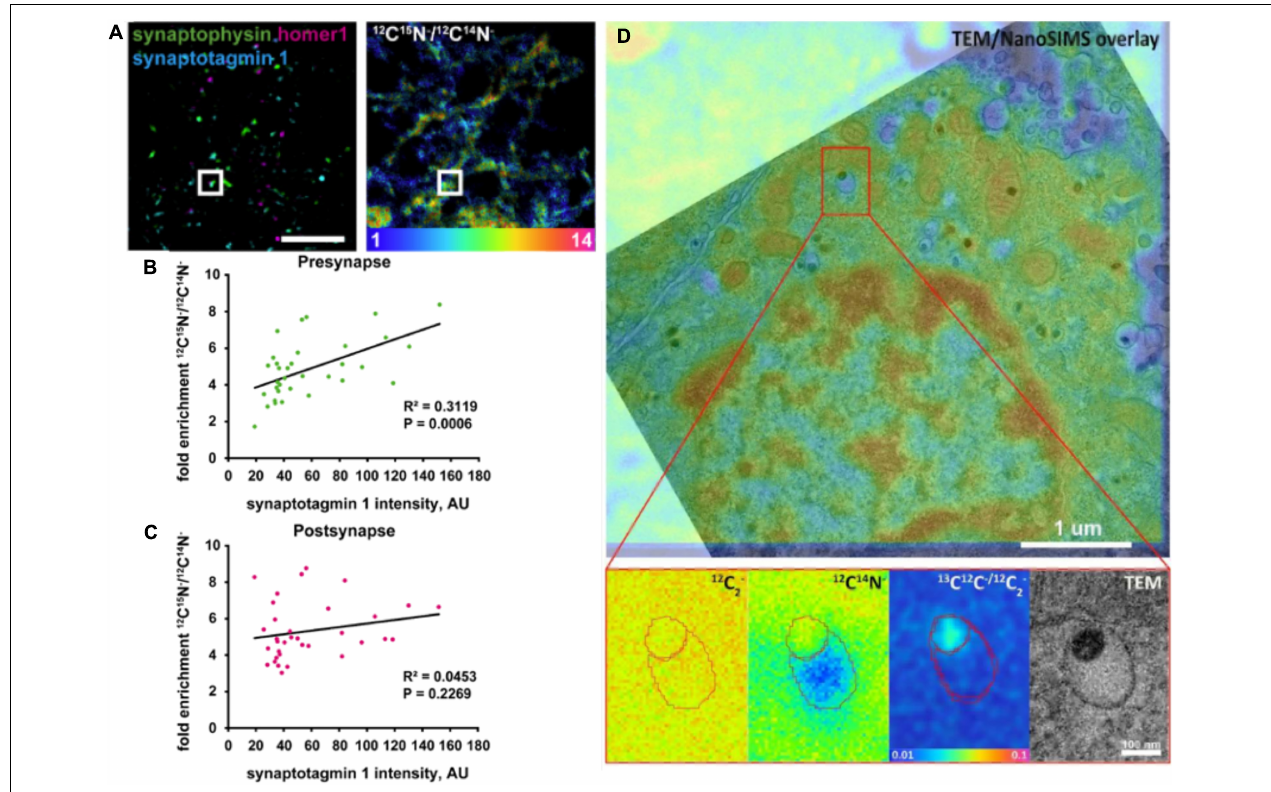
FIGURE 4 | Examples of correlative imaging with NanoSIMS in neurons and synapses. (A–C) Correlation of synaptic protein turnover with synaptic activity. (A) Stimulated emission depletion (STED) images localizing the pre- and post-synapses identified by presynaptic marker (Synaptophysin), postsynaptic marker (Homer 1), synaptic activity marker (Synaptotagmin 1), and their corresponding protein turnover shown in the 12 C 15 N/ 12 C 14 N NanoSIMS image. Scale bar is 5 µ m. (B) Quantitative chart showing the correlation of presynaptic protein turnover with synaptic activity. (C) Quantitative chart showing no correlation of postsynaptic protein turnover with synaptic activity. (D) Correlative TEM and NanoSIMS imaging of dense core vesicles in a PC12 cell incubated with 13 C-labeled L-DOPA. A higher concentration of 13 C-dopamine (87.5 mM) was found in the dense core compared to the halo (16 mM). The Figures were reproduced from Jähne et